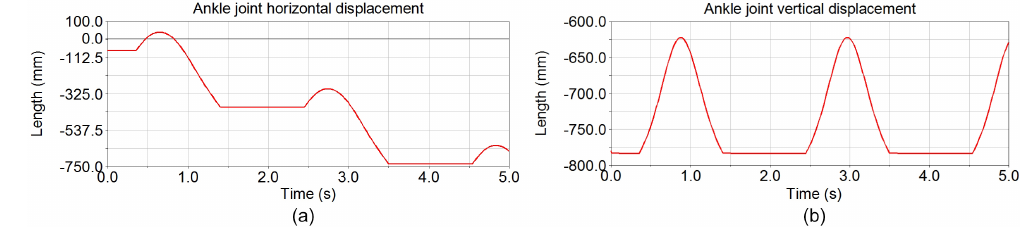
Figure 18. Computed displacement of the left leg exoskeleton ankle joint: (a) on x axis; (b) on y axis.